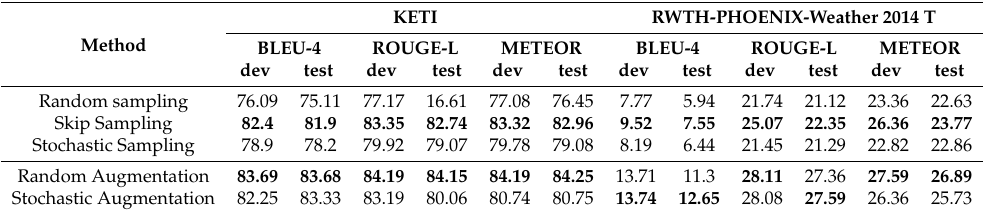
Table 3. (TOP) Comparison of SLT Performance by Sampling Method. (Bottom) Comparison of SLT Performance by Augmentation